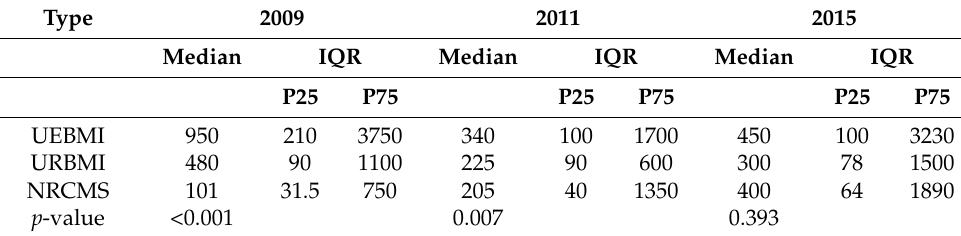
Table 3. Overall reimbursement amount by year and social health insurance schemes in China (RMB).